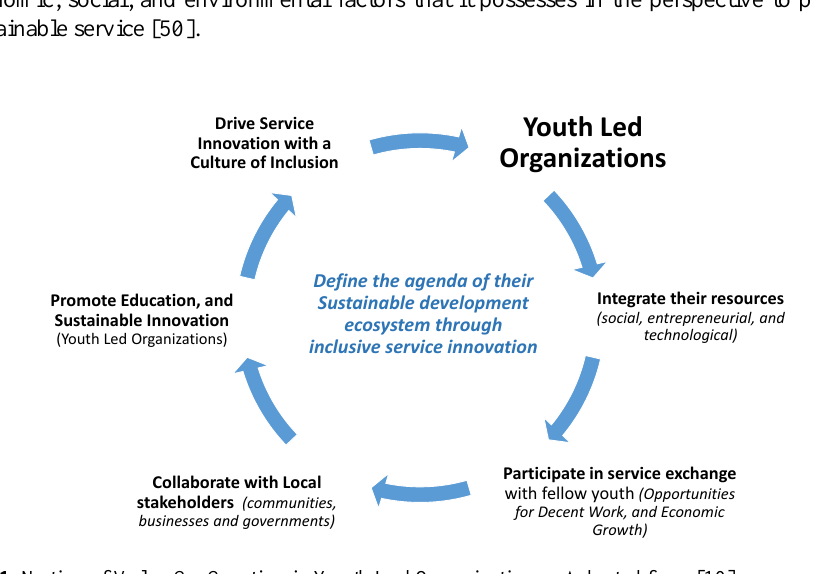
Fig. 1. Notion of Value Co-Creation in Youth Led Organizations – Adapted from